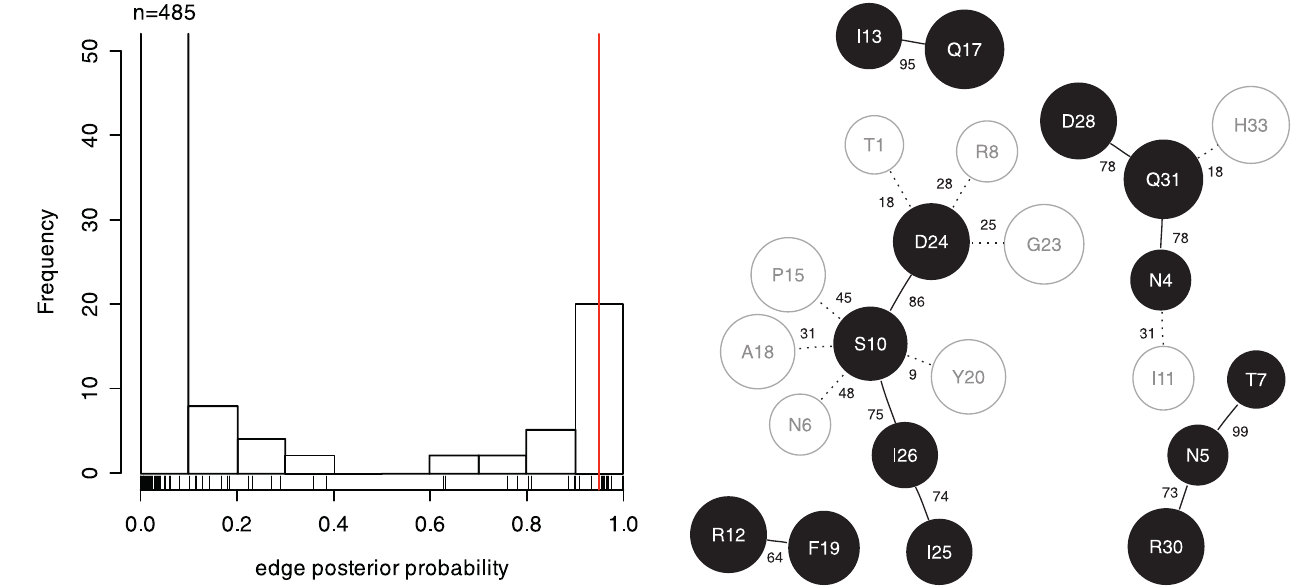
Figure 3. The Consensus Network of V3 Residues Each node corresponds to a residue in the V3 loop, numbered according to their position in the consensus sequence (identical to Korber et al. [19]) and labeled with the consensus amino acid. Dark-shaded nodes indicate residues that are connected by edges with parametric bootstrap support values exceeding 50%; each edge is labeled with its support value. Edges with support values below this threshold are indicated by dashed lines.